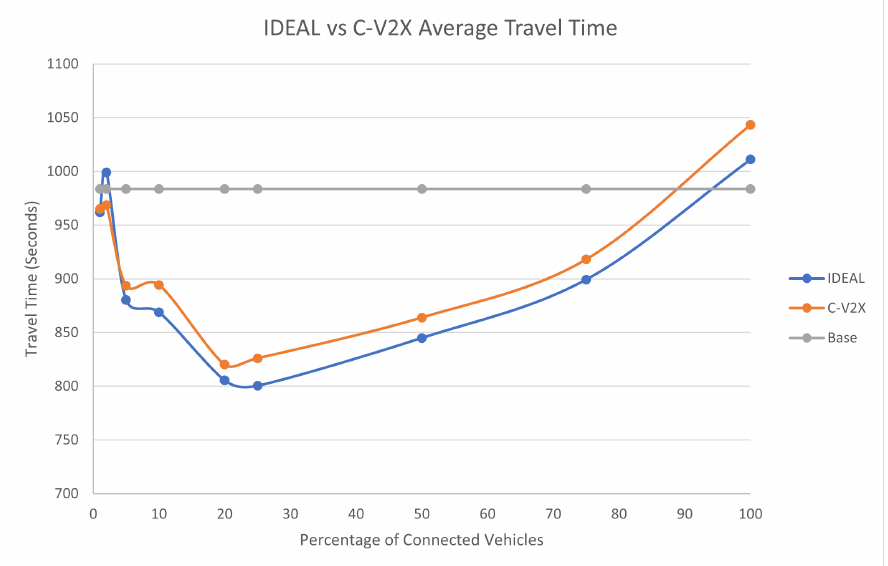
Figure 5. Average network-wide Travel Time of Energy-Efficient dynamic routing application using IDEAL and C-V2X communication on LA road network with traffic demand of scale factor 1.